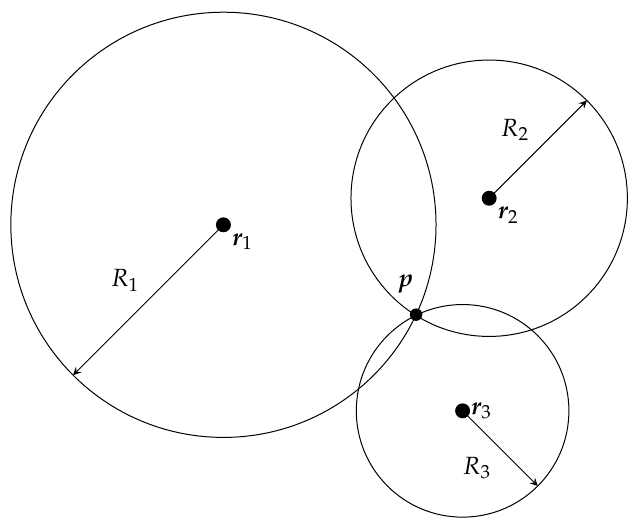
Figure 3. Spherical localization for determining the receiver position p as the intersection of circles in 2D or spheres in 3D of radius R i . The known positions of the beacons are denoted by r 1 , r 2 and r 3